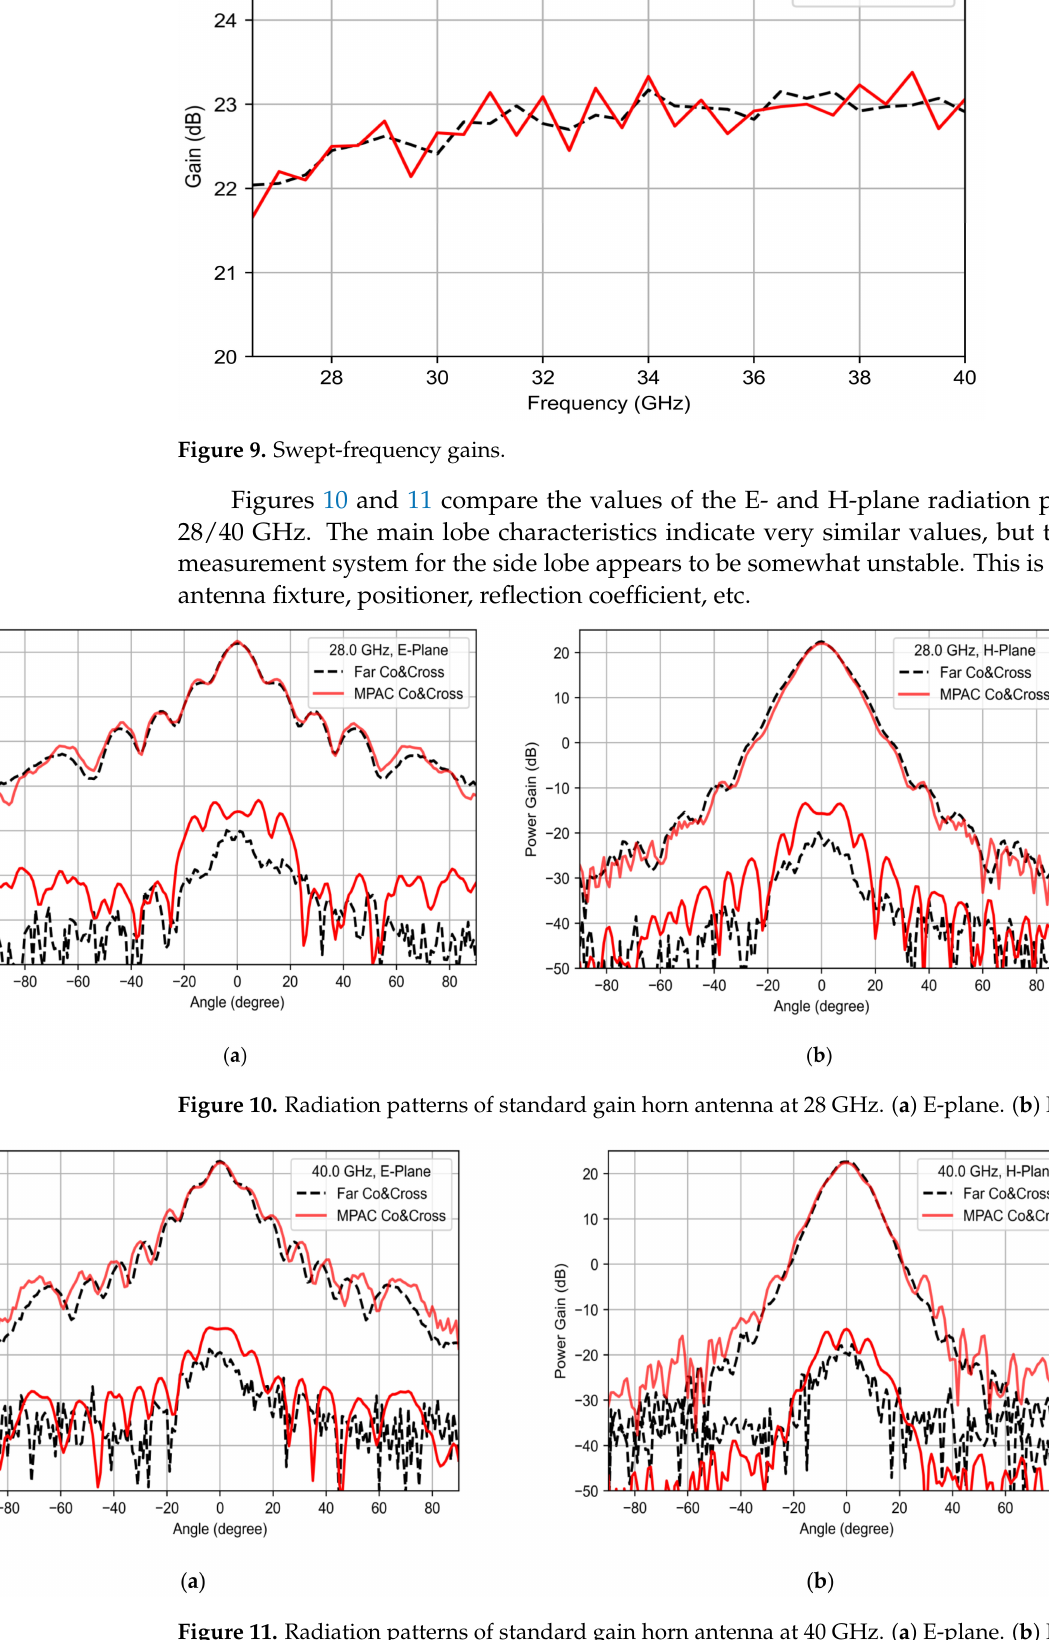
Figure 11. Radiation patterns of standard gain horn antenna at 40 GHz. ( a ) E-plane. ( b )